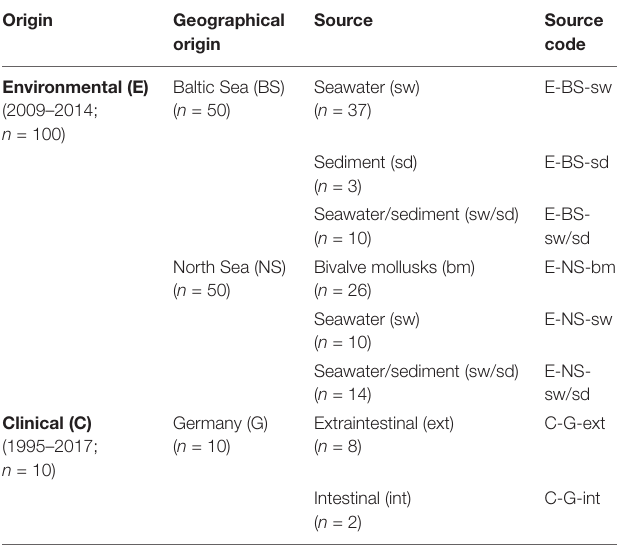
TABLE 1 | Origin and source of Vibrio cholerae non-O1, non-O139 strains ( n = 110) included in this study.